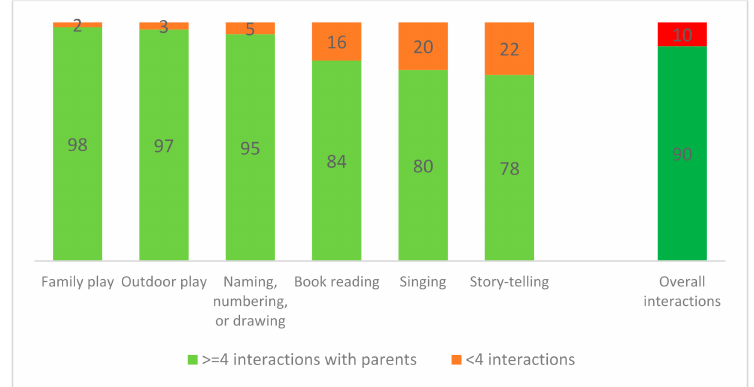
Figure 1. Percentage of the parental interactions by type.